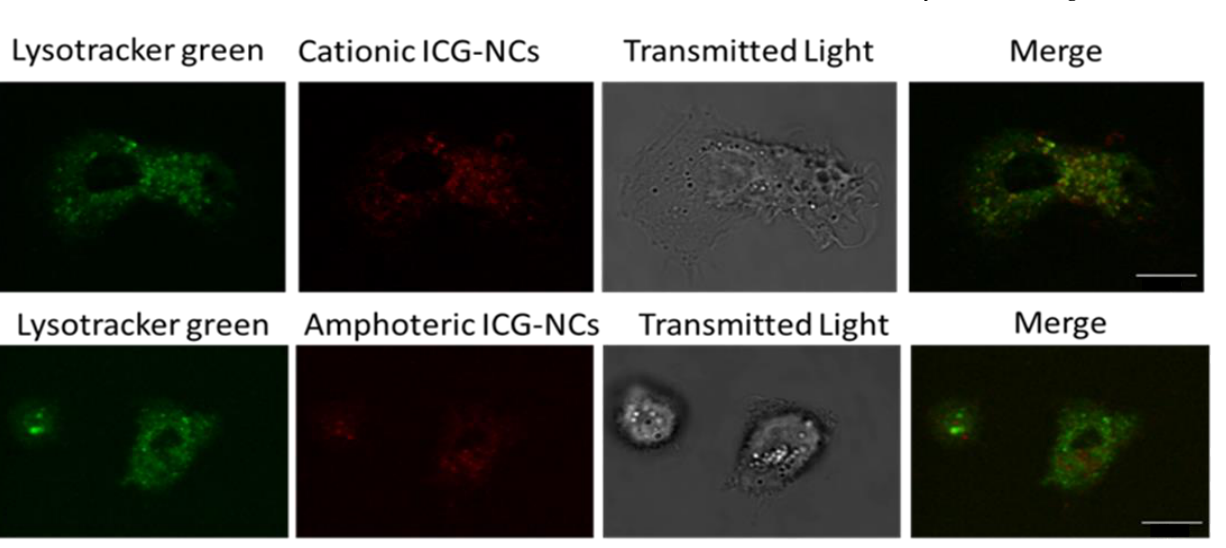
Figure 3. Cellular uptake by confocal microscopy of cationic and amphoteric ICG-loaded NCs in moDCs using multiphoton excitation. Both nanocapsules were incubated at 2 µM ICG concentration for 2 h at 37 °C. Scale bar: 10 μm.